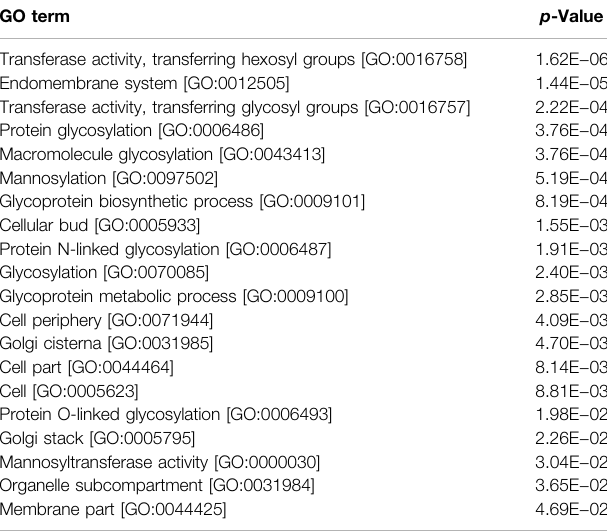
TABLE 1 | Gene Ontology analysis for genes with decreased translational ef fi ciency in Δ ntd compared to WT in the presence of urea. GO